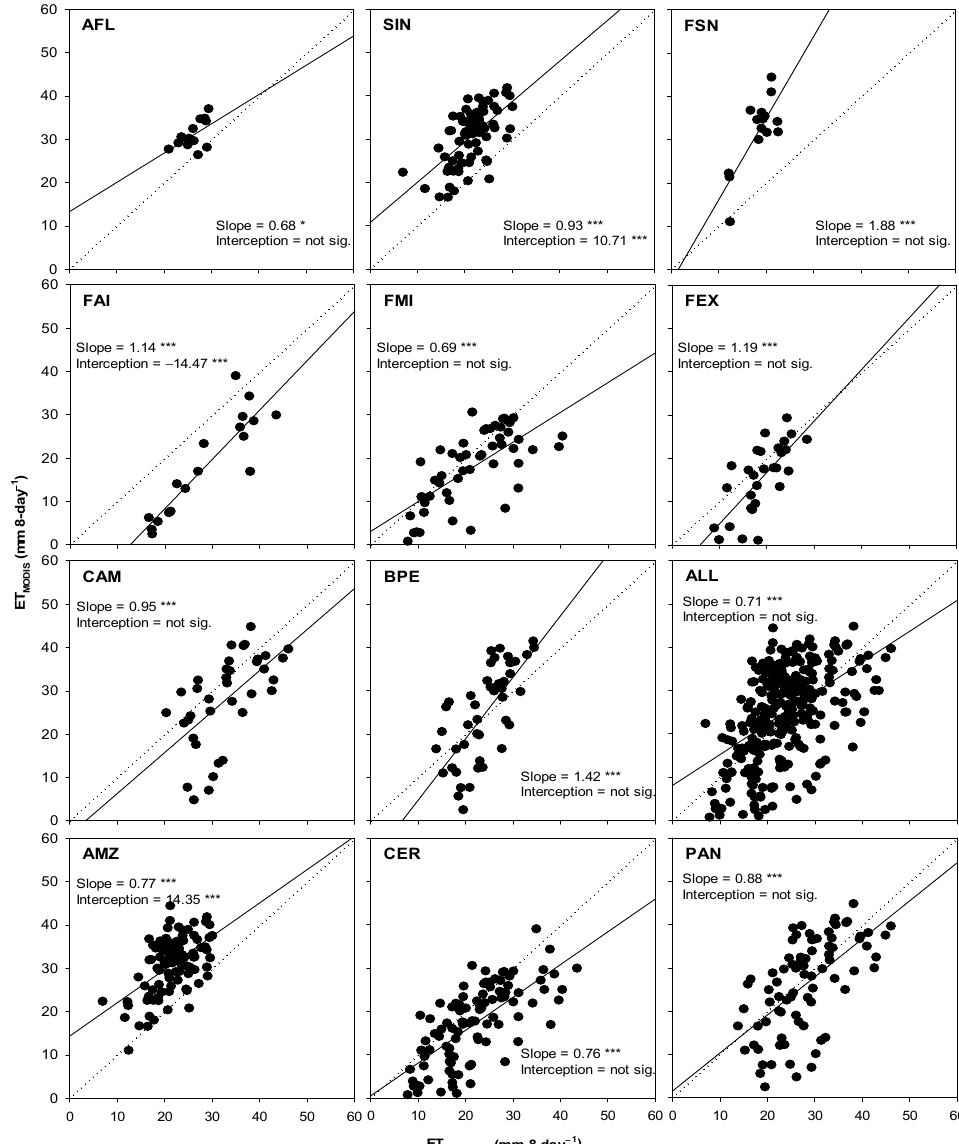
Figure 4. Scatterplot of cumulative measured (ET Measured ) and estimated (ET MODIS ) 8-day evapotranspiration (mm 8-day − 1 ) in each site in the Amazon (AMZ), Cerrado (CER), and Pantanal (PAN) sites, and then in all sites (ALL). The slope and intercept coefficients values of the regression are accompanied by (*) indicate p -value < 0.05, and (***) p -value < 0.001.